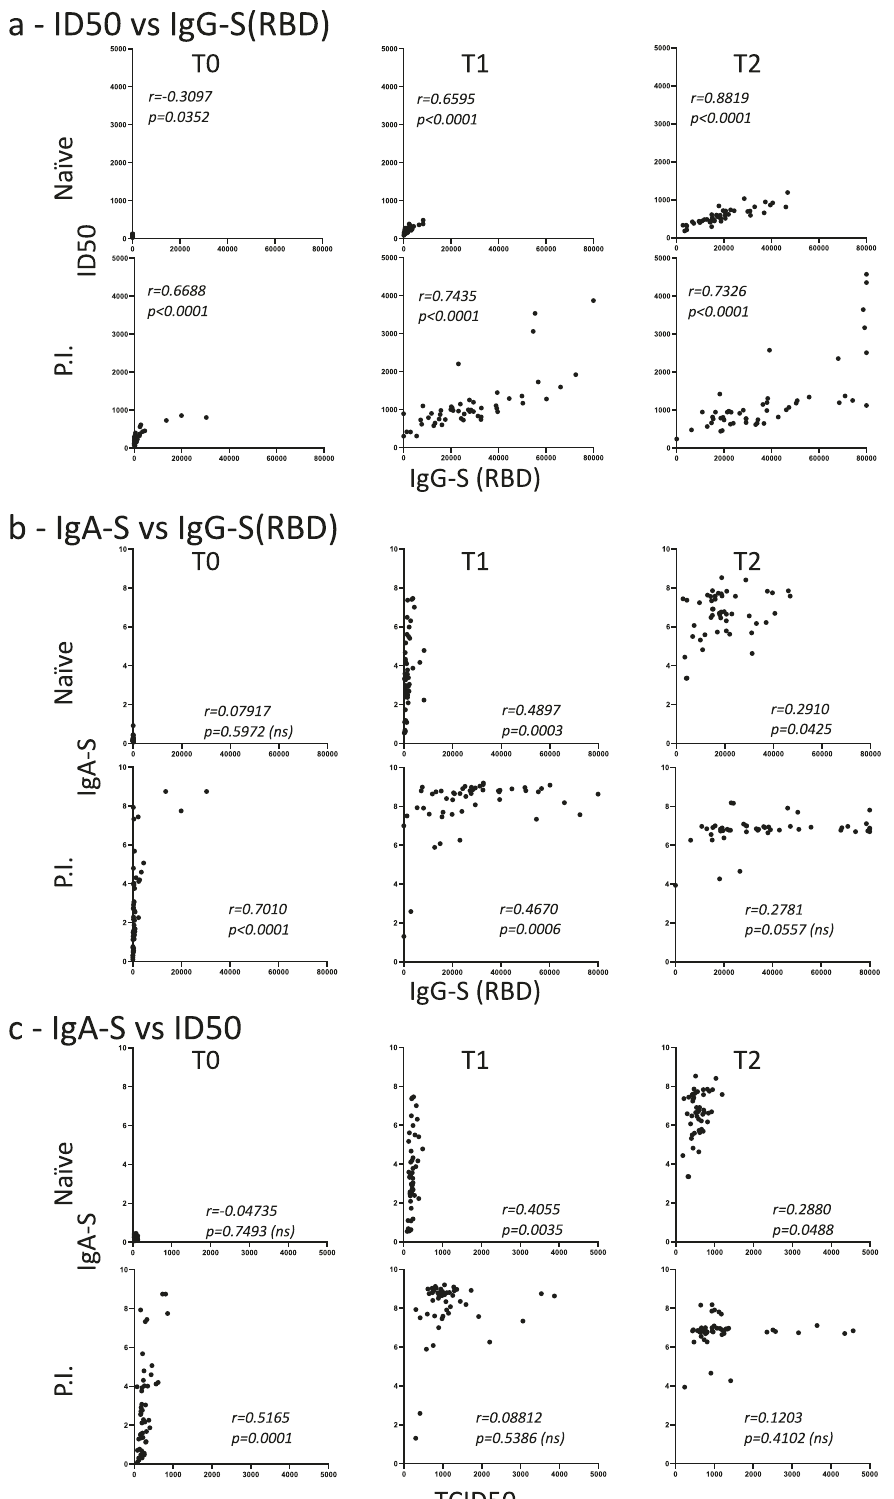
Fig. 3 Analysis of the correlation at time of fi rst vaccination (T0), second vaccination (T1), and 3 weeks after (T2) in naïve and previously infected (P.I.) recipients. a correlation between IgG-S(RBD) and neutralization (ID50) (sample sizes: T0 n = 48, T1 n = 50, T2 n = 49 for naïve, T0 and T1 n = 51, T2 n = 49 for P.I.); b correlation between IgG-S(RBD) and IgA (sample sizes: T0 n = 48, T1 n = 50, T2 n = 49 for naïve, T0 and T1 n = 51, T2 n = 49 for P.I.); c correlation between neutralization (ID50) and IgA-S (sample sizes: T0 n = 48, T1 n = 50, T2 n = 49 for naïve, T0 and T1 n = 51, T2 n = 49 for P.I.). The correlation was calculated using the two-sided Spearmen rank-correlation